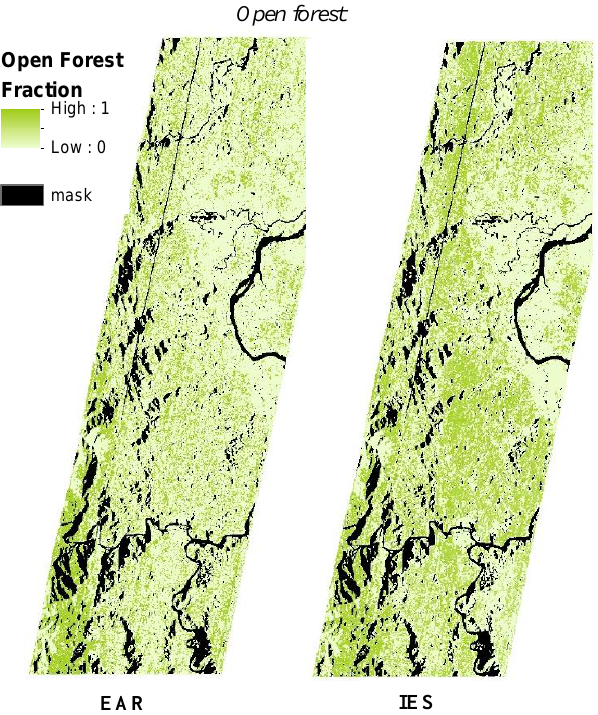
Figure 5. Fractional cover of open forest based on MESMA